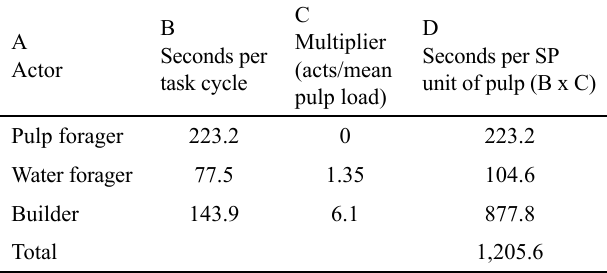
Table 1 . Series-parallel (SP) system of nest construction. For each actor (column A), the time required per task cycle (column B) is multiplied by the number of cycles (column C) of that task required to process one standard load brought in by a pulp forager. The result is the number of seconds required by that actor to service the standard load (column D). Times are in seconds and include times in queue on the nest. Data from Jeanne (1986, Table 2, large